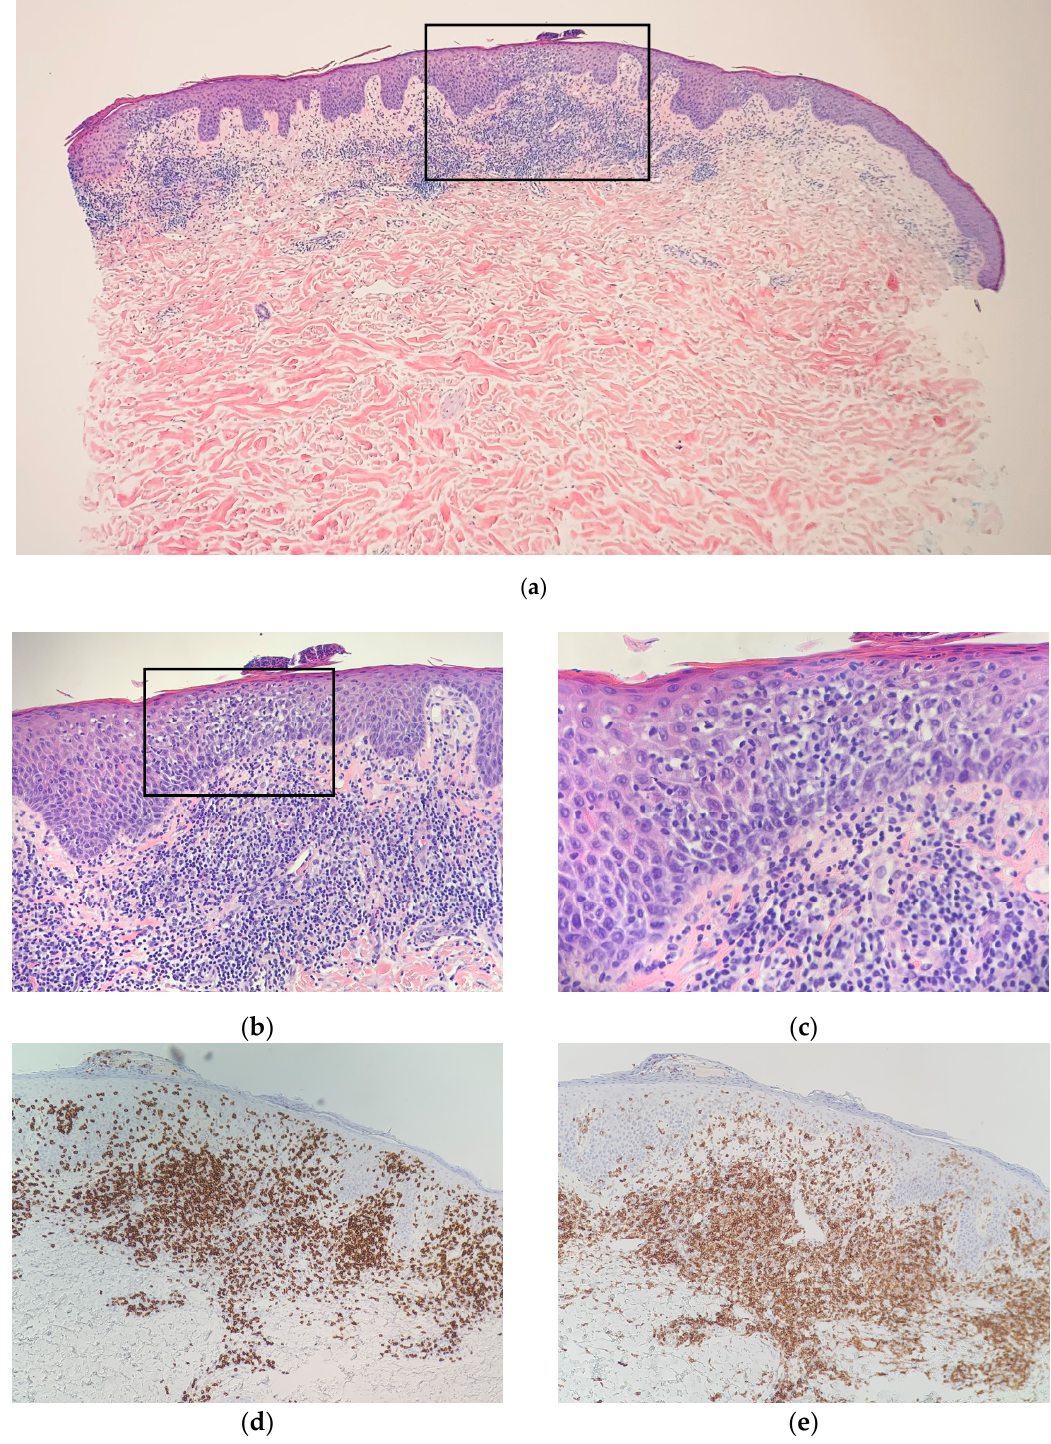
Figure 2. Left mid-back punch-biopsy histology (hematoxylin-eosin) showing interface dermatitis with hyperchromatic, angular, atypical lymphocytes in the epidermis and at the dermal–epidermal junction with accompanying papillary dermal-fibrosis at magnification ( a ) ×20; ( b ) ×40; ( c ) ×100; ( d ) Immunohistochemical staining of CD8, magnification ×40; ( e ) Immunohistochemical staining of CD4, magnification ×40. Consistent with CD8+-predominant mycosis fungoides (cutaneous T-cell lymphoma).